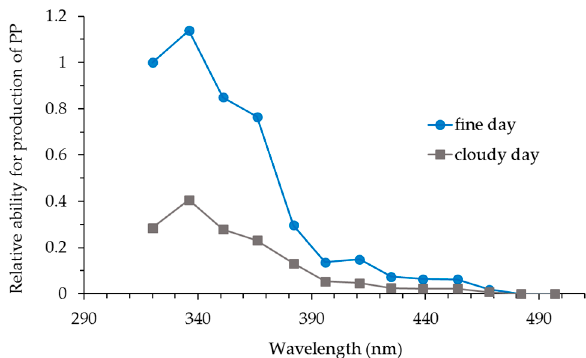
Figure 5. Product curve of persistent pigmentation (PP) by sunlight calculated by spectral distribution of sunlight in Figure 4.